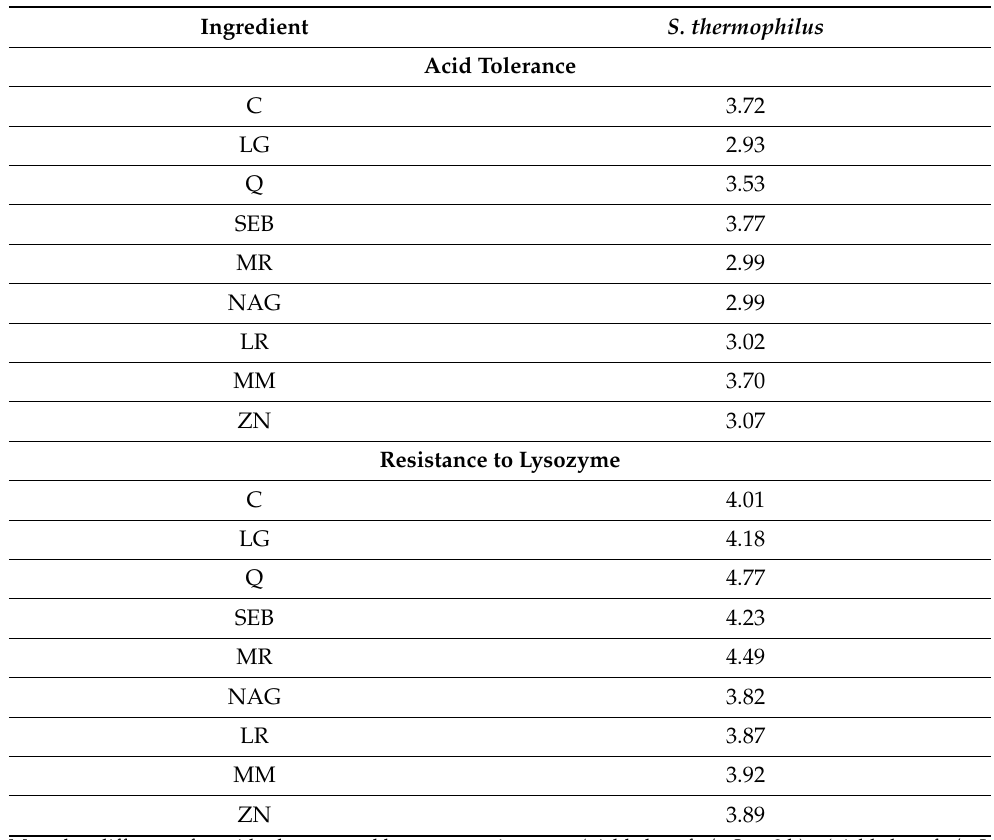
Table 3. Mean log difference (log cfu/mL) in the acid tolerance and resistance to lysozyme counts of Streptococcus salivarius ssp. thermophilus ST-M5.